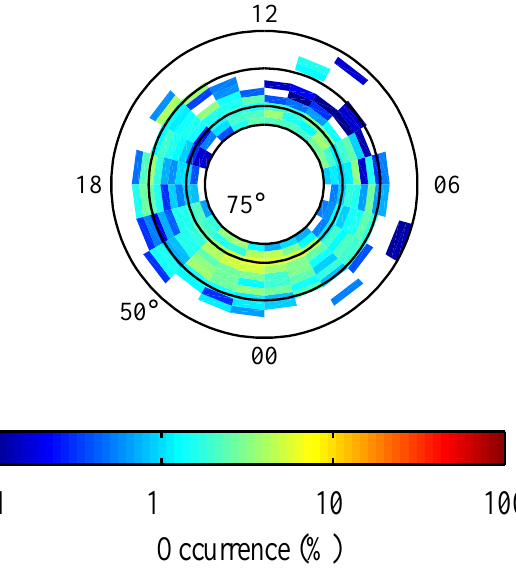
Fig. 1. Occurrence of ion energization versus MLT and INV. The locations of 50 ◦ , 60 ◦ , 70 ◦ , and 75 ◦ INV are indicated with solid